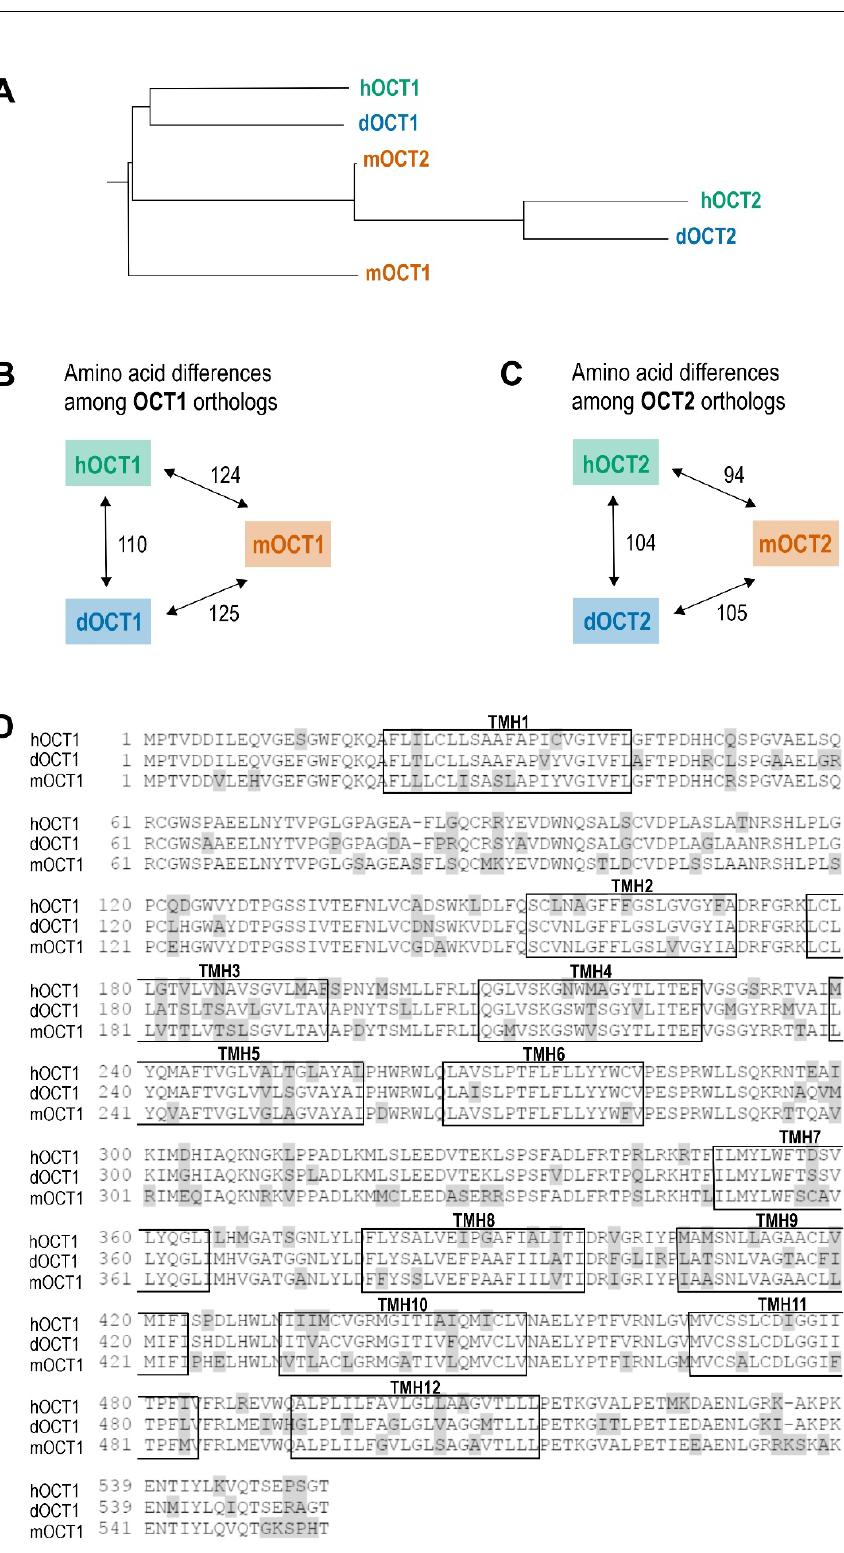
Figure 2. Protein sequence comparison of OCT1 and OCT2 orthologs of human, mouse, and dog. ( A ) Phylogenetic tree showing the similarities of human, dog, and mouse OCT1 and OCT2 protein sequences. Branch lengths not to scale. ( B , C ) Number of amino acid differences between dog, hu- man, and mouse OCT1 ( B ) and OCT2 ( C ). ( D ) Alignment of human, dog, and mouse OCT1 protein Scheme 1. are shown in boxes. Sequences were compared using clone manager suite v.9.0 and the BLOSUM62 algorithm.